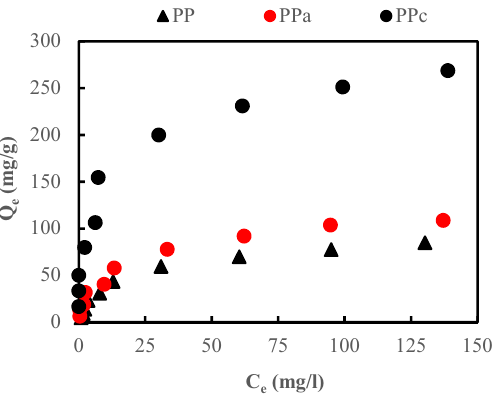
Figure 8. Sorption isotherms of CB for the native and modified sorbents (m (PP) = m (PPa) = 2 g/L; m (PPc) = 0.6 g/L; pH = 2.2).